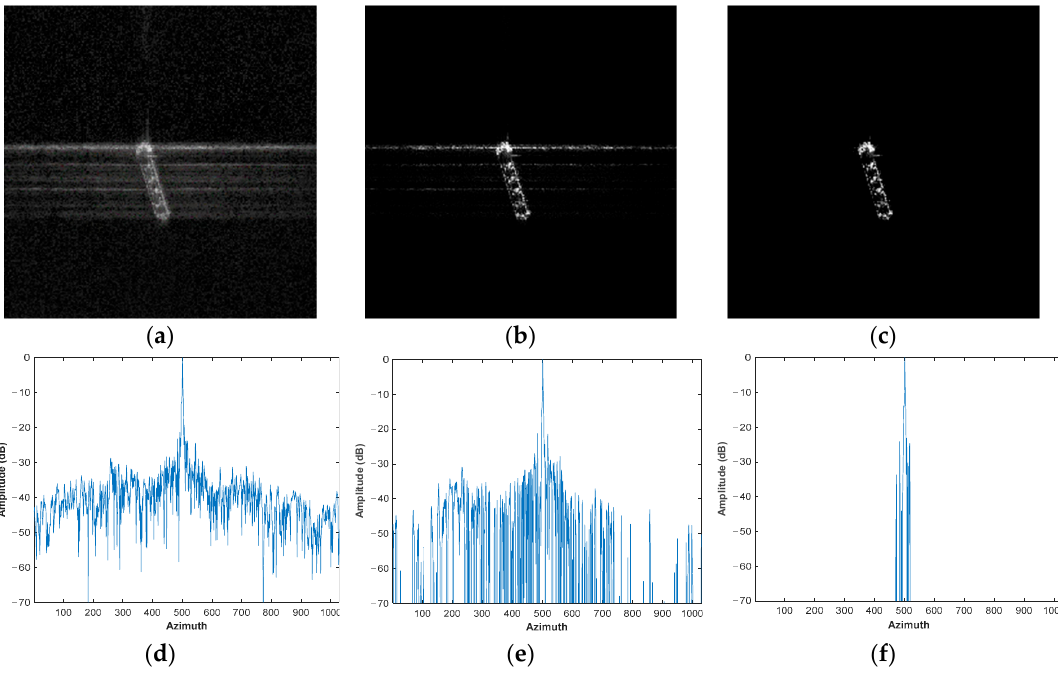
Figure 5. Airborne SAR data imaging results. ( a ) MF. ( b ) Parameter estimation method based on complex image, with K mid = 0.21. ( c ) The proposed method, with K opt = 0.02. ( d ) The azimuth profile of the imaging result of MF, with ISLR being − 6.59 dB. ( e ) The azimuth profile of the imaging result of the adaptive parameter estimation method based on complex image, with ISLR being − 9.14 dB. ( f ) The azimuth profile of the imaging result of the proposed method, with ISLR being − 10.55 dB.